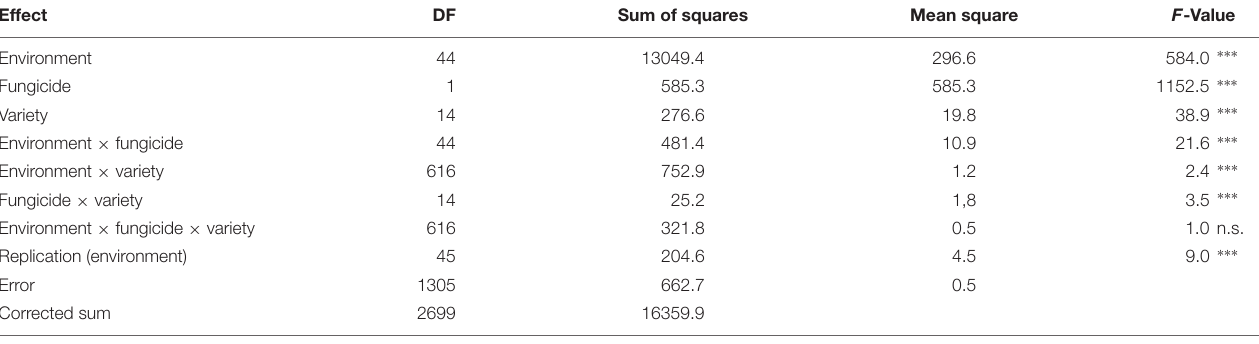
TABLE 4 | Analysis of variance for factors influencing white sugar yield of 15 sugar beet varieties tested at 45 environments in Germany 2014–2016.